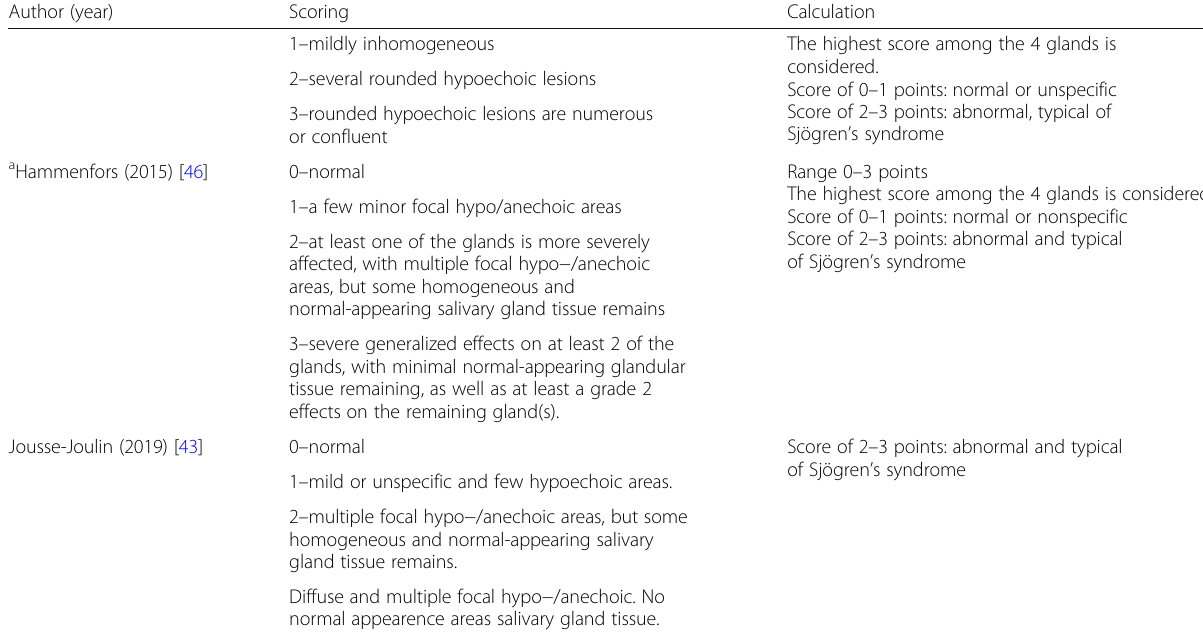
Table 5 Scoring systems for salivary gland ultrasound findings in patients with Sjögren ’ s syndrome, considering the bilateral submandibular glands and parotid glands (Continued) Author